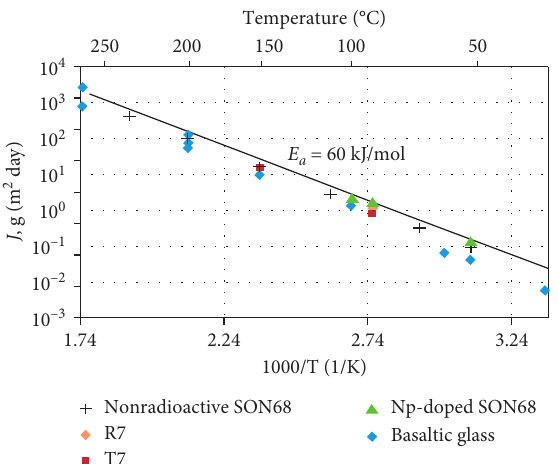
Figure 7: Temperature dependence of leaching rate of α -irradiated and nonirradiated glasses [6]. Table 9: Effect of c -irradiation on leaching rate of glass PNL 76–68 with account for radiolysis [54].